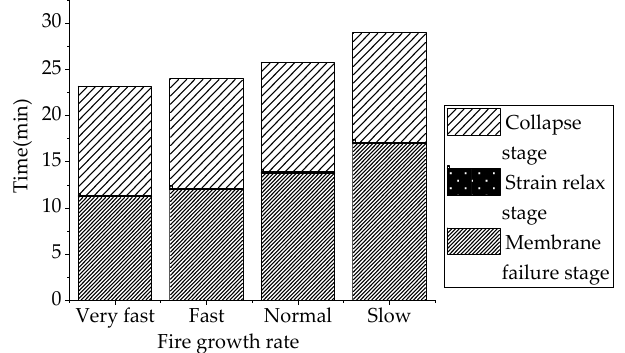
Figure 17. Pressure difference after the membrane failure. In the case of an air-supported-structure fire, the time required for the final destruction of the structure can be regarded as the sum of the time span from the fire breaking out to the membrane failure, and the time span of the strain relax and time of collapse stages. The final destruction times of different fire events are shown in Figure 18. The destruction times range from 20 min to 30 min in different fire events. The destruction time is mainly determined by the time of the membrane failure.